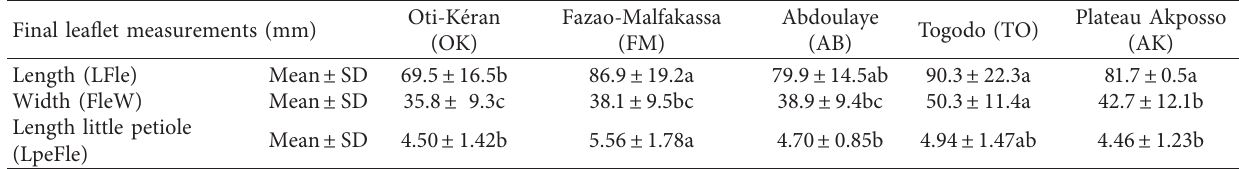
Table 9: Mean values of the terminal leaflet features of populations.